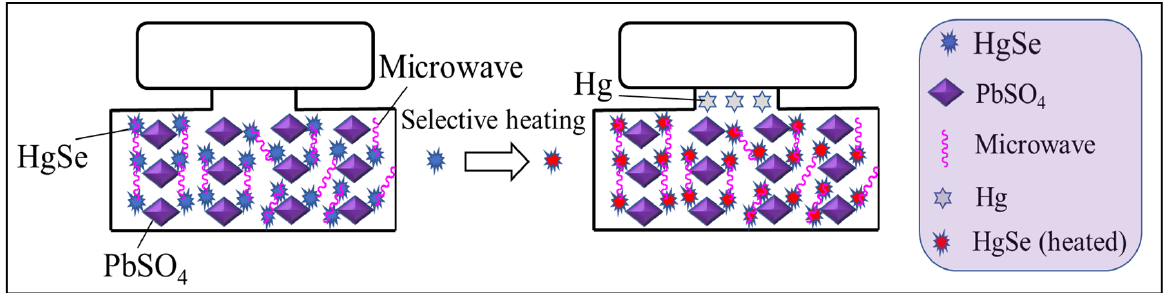
where, ε (cid:48) = dielectric constant of the mixture; v i = volume fraction of the i th constituent; ε (cid:48) Figure 6. ( a ): Heating curve of MAM by microwave heating (800 W); ( b ): Heating curve of PbSO 4 ε (cid:48) = dielectric constant of the i th, j th constituent, respectively; n = number of constituents in j (20 g) by microwave heating (800 W); ( c ): Heating curve of MAM by conventional heating (2700 W). the sample. Figure 7. Mechanism diagram of the recovery of mercury from MAM by microwave heating.